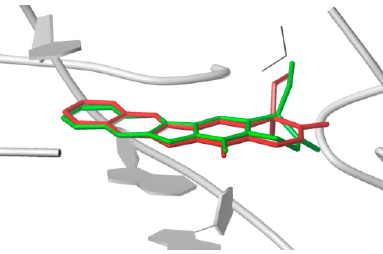
Figure 6 . Result of validation for Topo I inhibitor (CPT) inside the enzyme active site (derived from PDB ID